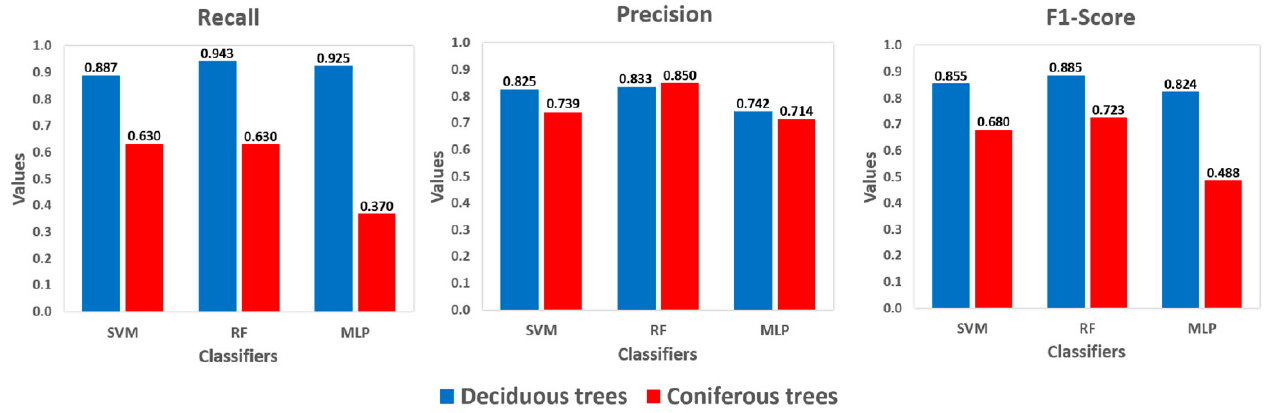
Figure 9. Recall, precision, and F1-score values of SVM, RF, and MLP classification algorithms for each deciduous and coniferous tree species.